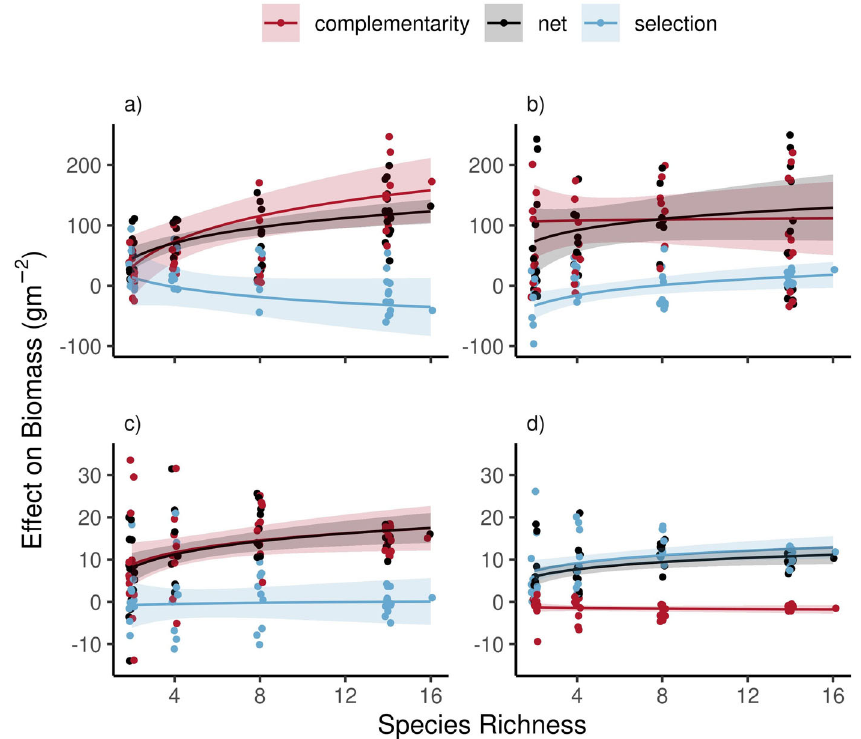
Fig. 3 Observed and predicted plant-community biomass responses to species richness. Data from experiments performed in 2014 and 1997 are shown in panels a and b , respectively. Data from simulation models that either included or excluded plant-soil feedback effects shown in panels c and d , respectively. Data from Net effects (black symbols) were separated mathematically into complementarity effects (red) and selection effects (blue). Plant- community simulation models that included plant-soil feedbacks correctly predicted that plant growth would increase with richness due to complementarity effects ( c ; red line) while the same models without plant-soil feedback effects incorrectly predicted positive selection effects ( d ; blue line) and negative complementarity effects ( d ; red line). Shaded areas indicate the 95% con fi dence intervals. Data from 63 ( a ) or 55 ( b ) different replicated plant communities. In each dataset, the net biodiversity effect increased with species richness ( P < 0.05; see Results for